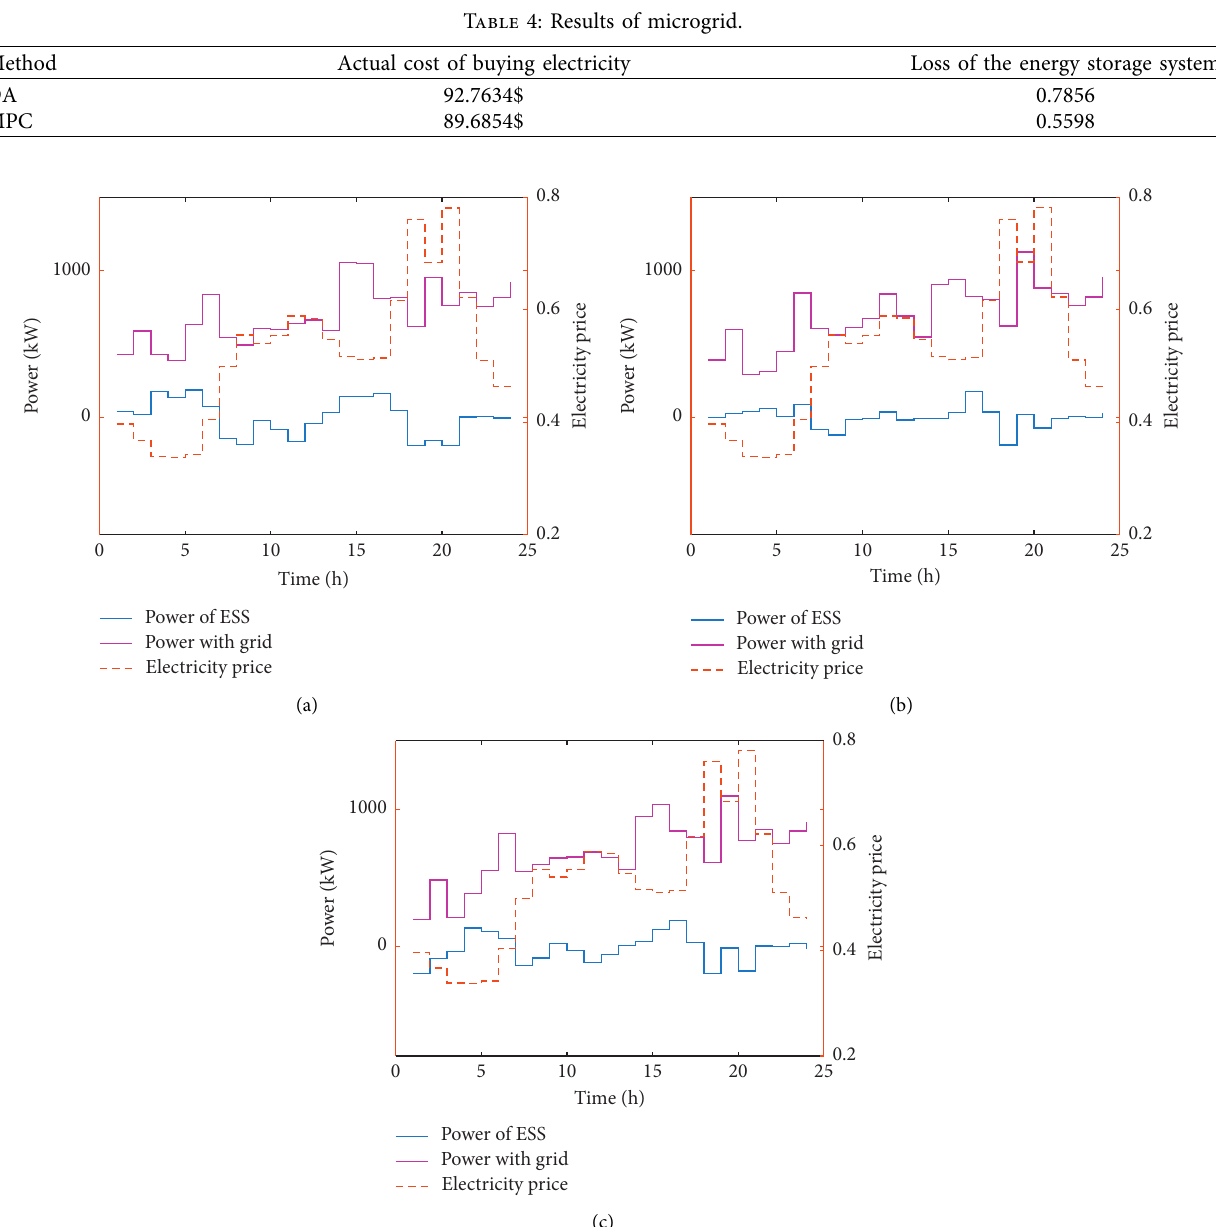
Figure 7: Operation states of different components: (a) w � [ 0 . 1 , 0 . 9 ] ; (b) w � [ 0 . 9 , 0 . 1 ] ; (c) knee.